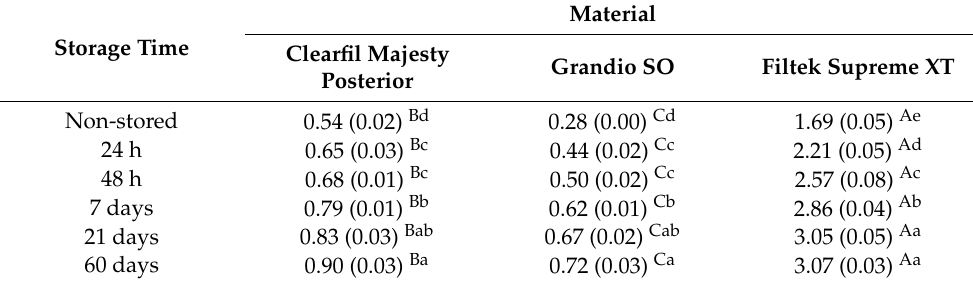
Table 2. Means (standard deviation) of water content measured in wt% according to material and storage time ( n = 5).